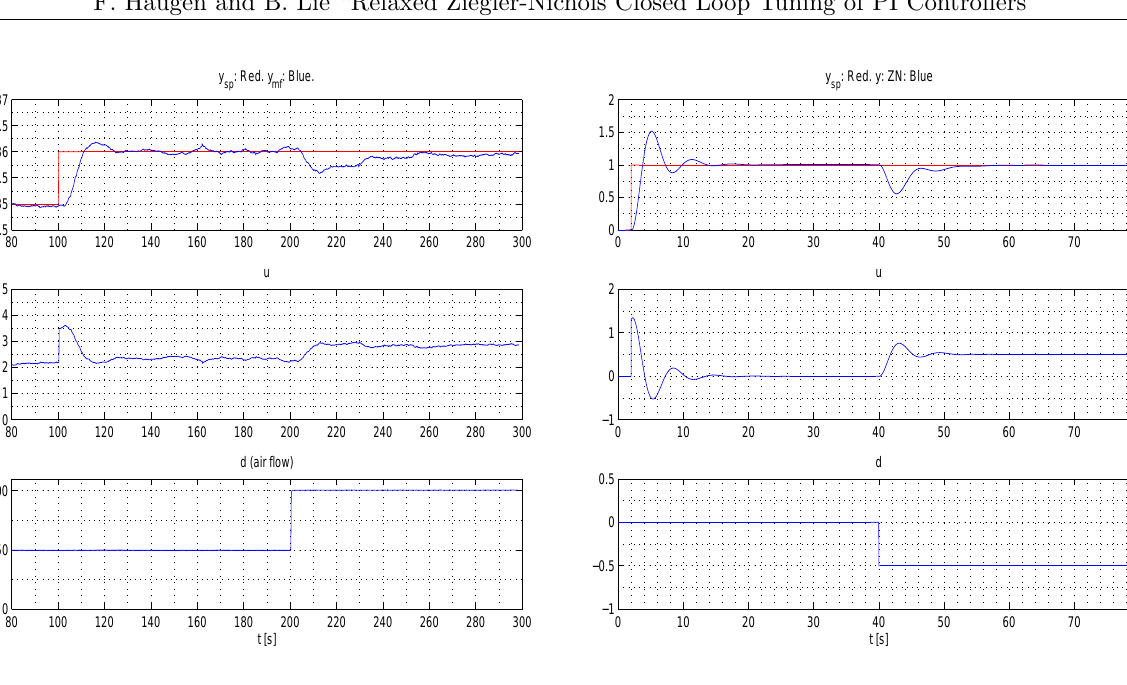
Figure 14: Responses with PI controller tuned with the R-ZN method with k r = 4.